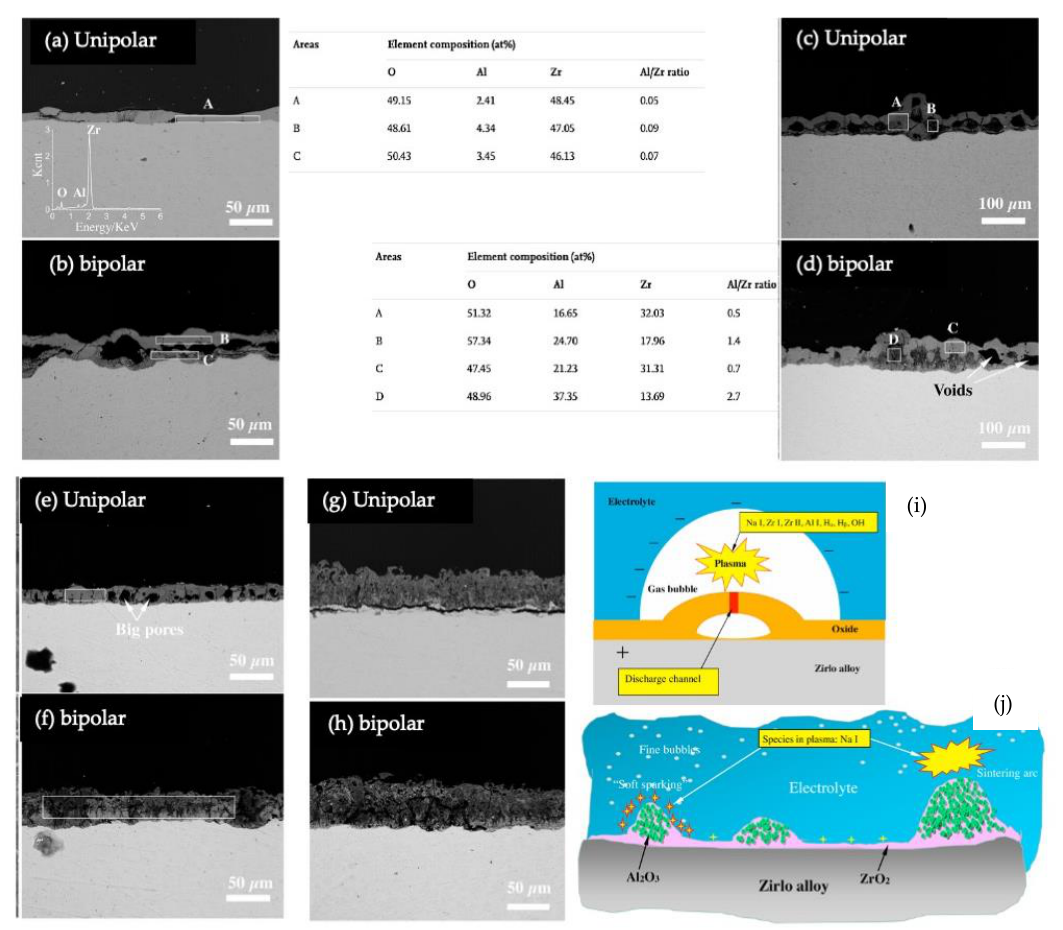
Figure 8. The cross-sectional images of the coatings under unipolar and bipolar regimes in electrolyte containing: ( a , b ) 2 g/L NaAlO 2 + 1 g/L KOH; ( c , d ) 16 g/L NaAlO 2 + 1 g/L KOH; ( e , f ) 32 g/L NaAlO 2 + 1 g/L KOH; ( g , h ) 56 g/L NaAlO 2 + 1 g/L KOH; ( i ) Schematic illustration of the growth steps through discharge penetration; ( j ) Schematic illustration of the coating formation process in highly concentrated electrolyte and under unipolar regime [33] (reproduced with permission number: 5043511188587,